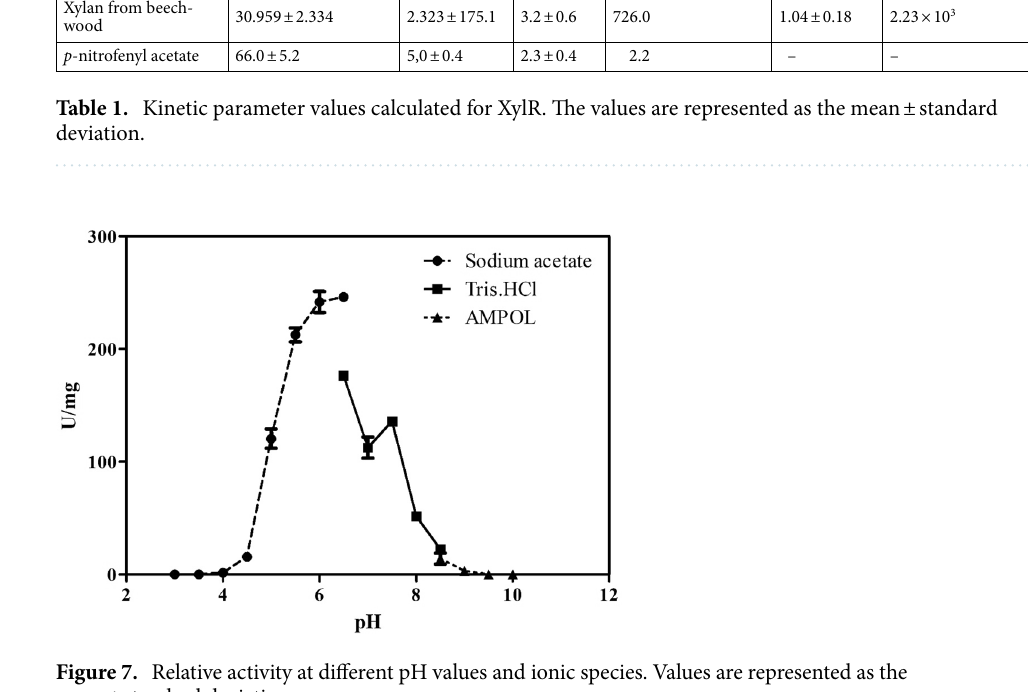
exposure to 2.5 M NaCl for up to 4 h, and at least 50% enzymatic activity was maintained with further exposure to this treatment for 8 h (Fig. 11). XylR is tolerant to organic solvents.